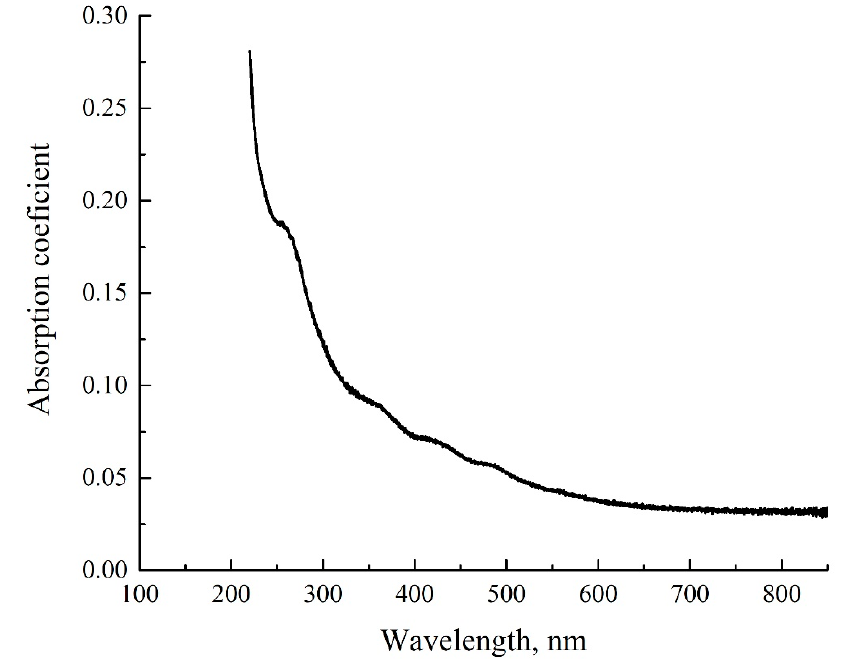
Figure 2. The absorptivity spectrum of dry Nafion.